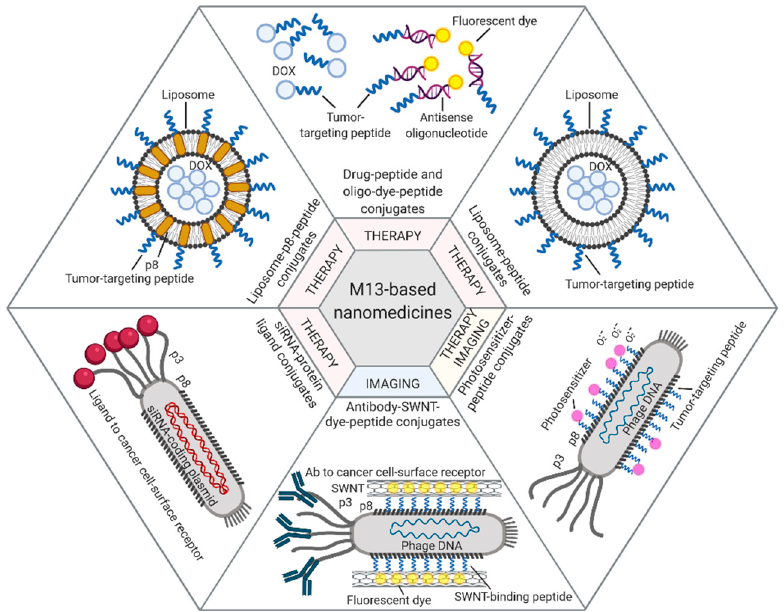
Figure 1. M13-based applications. Examples of therapeutic and diagnostic approaches exploiting M13 phage display-derived peptides [40,42], capsid proteins [44,45], and whole phages [46,48,50] as carriers for tumor-targeted delivery of drugs (e.g., Dox, antisense oligonucleotides, photosensitizers) or imaging dyes (e.g., fluorescein, NIR-SWNTs). Figure created with BioRender.com.